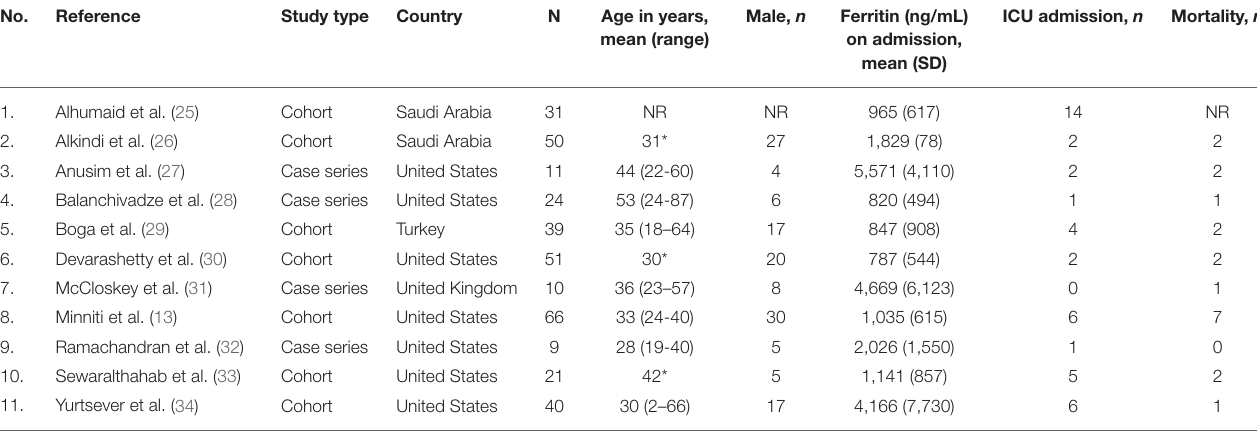
TABLE 1 | Characteristics of studies included.